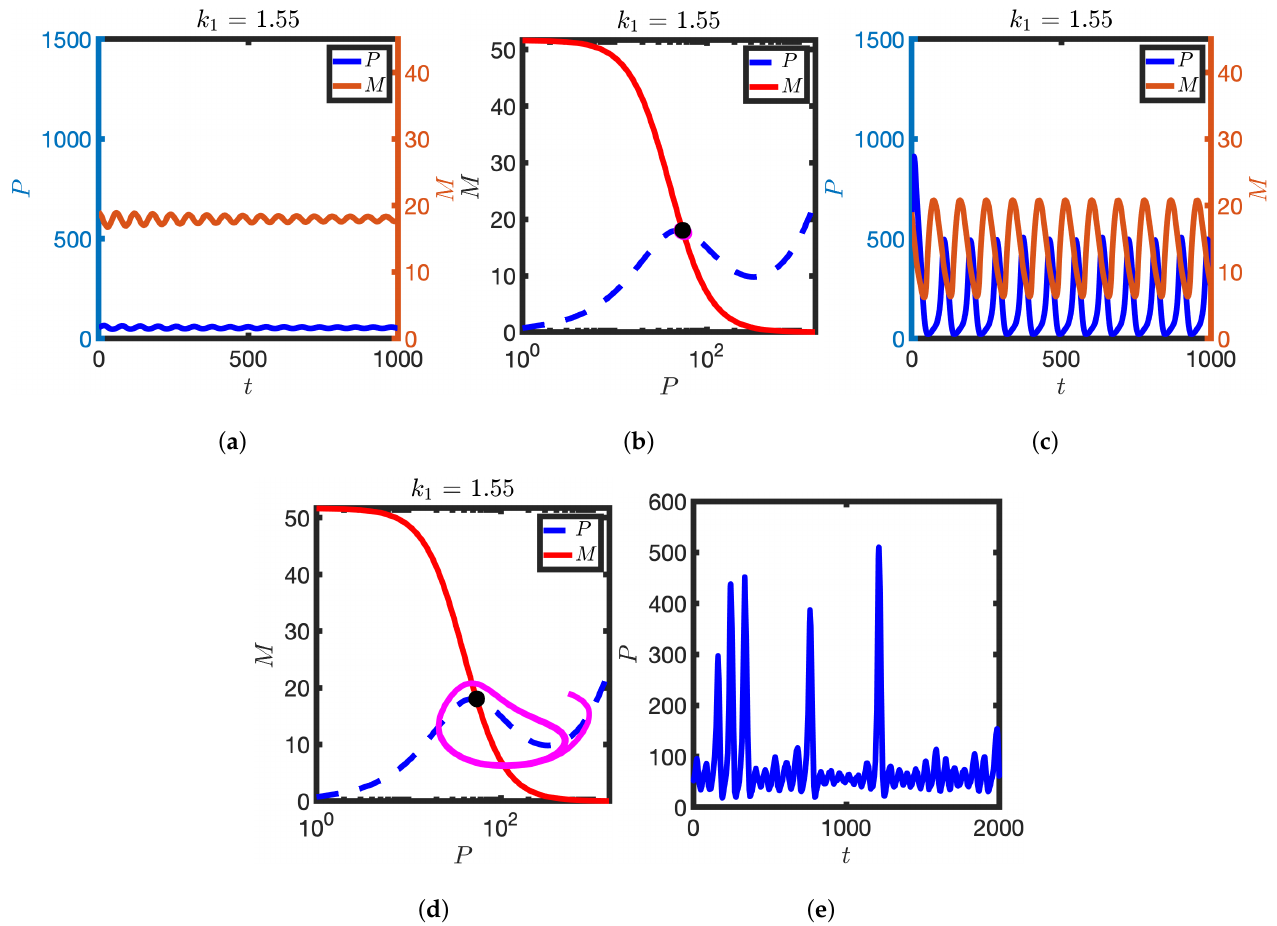
Figure 4. The emergence of a stable limit cycle upon further increase in the parameter k 1 . ( a , b ) Solution dynamics following a small perturbation about the steady state. M 0 = 54, P 0 = 19. ( a ) P and M are plotted against time, t . ( b ) Corresponding solutions (magenta lines) are plotted in the PM phase plane. P nullclines (dashed blue lines), M nullclines (solid red lines), steady states (black dots). ( c , d ) A larger perturbation about the steady state results in a stable limit cycle. M 0 = 540, P 0 = 19. Other details as in ( a , b ). Equation (2) were solved numerically. ( e ) Intermittent oscillations: noise allows for stochastic switching between stable limit cycle and the stable steady state. P is plotted against time, t . Equation (3) were solved numerically. k 1 = 1.55. Other parameters as in Table